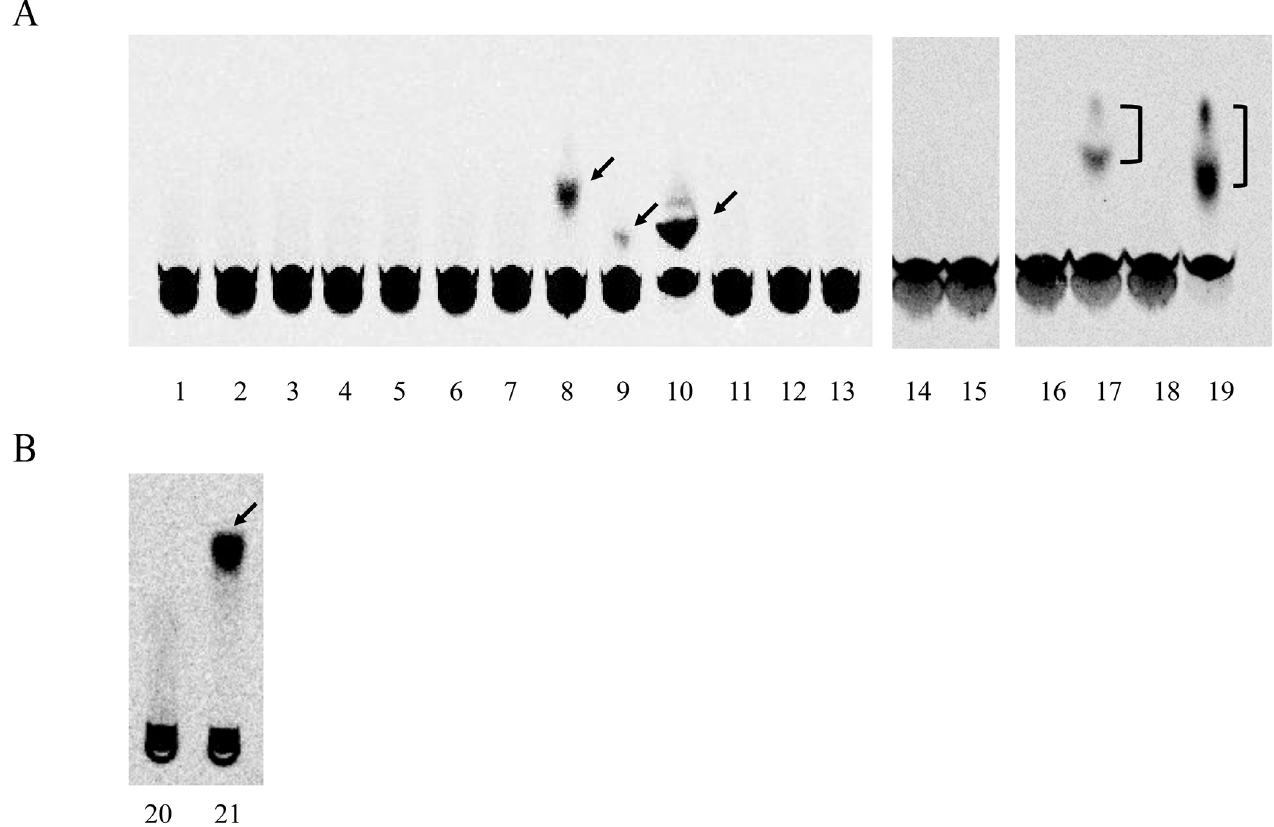
Fig 3. Thin-layer chromatography (TLC) of [ 35 S] sulfated derivatives produced by sw SULT ST3 with various substrates. Representative autoradiographs derived from TLC plates after elution are shown here. Lane numbers for (A) and (B) indicate 1) DMSO, 2) p -nitrophenol, 3) 1-naphthol, 4) naphthylamine, 5) dopamine, 6) serotonin, 7) triiodothyronine, 8) daidzein, 9) resveratrol, 10) xanthurenic acid, 11) 17 β -estradiol, 12) dehydroepiandrosterone, 13) corticosterone, 14) chlorogenic acid, 15) caffeic acid, 16) rutin, 17) genistein, 18) catechin, 19) apigenin, 20) DMSO, and 21) quercetin. Cellulose (A) and silica gel (B) TLC plates were used. The arrows and square brackets indicate the sulfated products of each substrate.